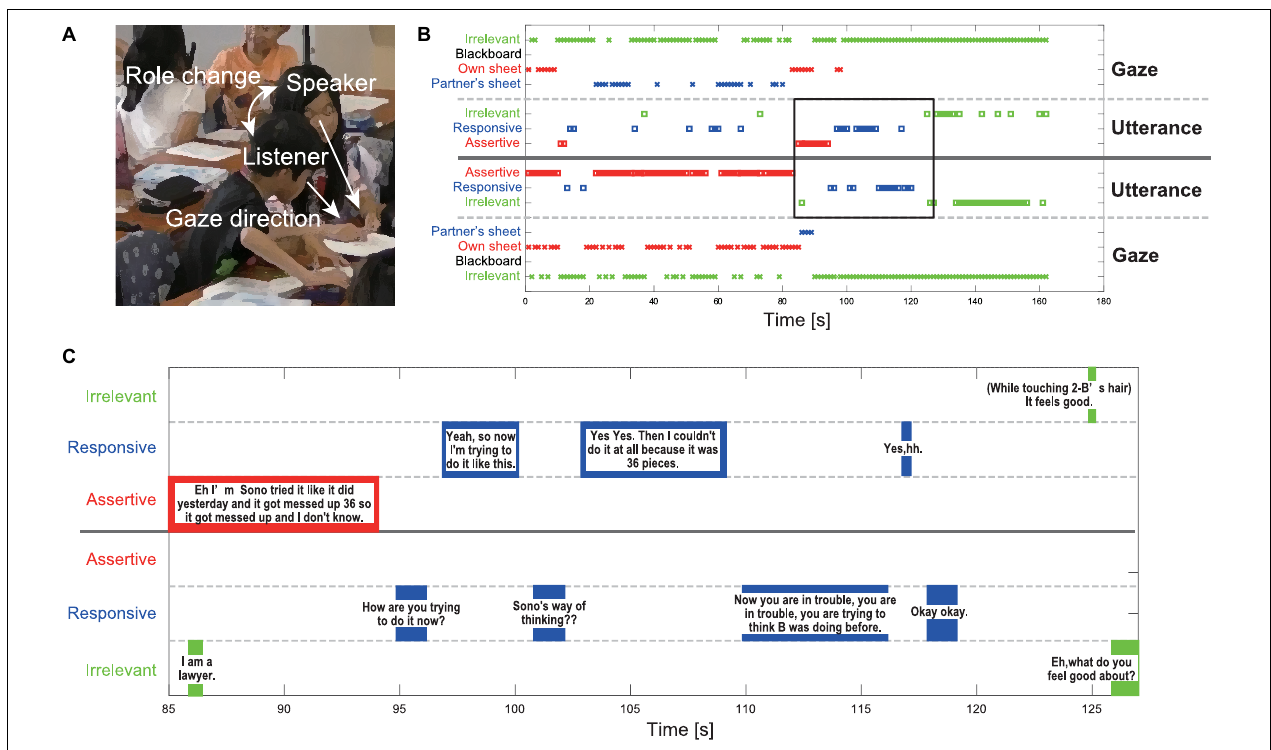
FIGURE 3 | Examples of recording and analysis of cognitive tasks. Panel (A) shows a part of the recording view for the cognitive task, which is the understanding of partitive division through pair activity in the math classes. Panel (B) illustrates the time series of the four types of gaze directions and three categories of utterances during the pair activity of two children. Panel (C) demonstrates three specific categories of utterances during a pair activity between two children corresponding to the box in panel (B) .